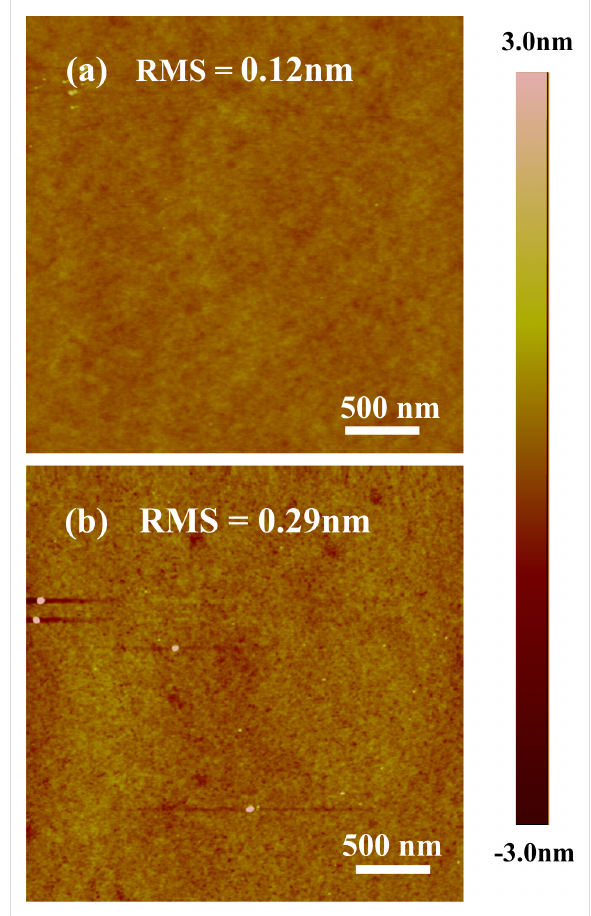
Figure 3: AFM images of (a) as received SOI (b) SOI after MLD processing.